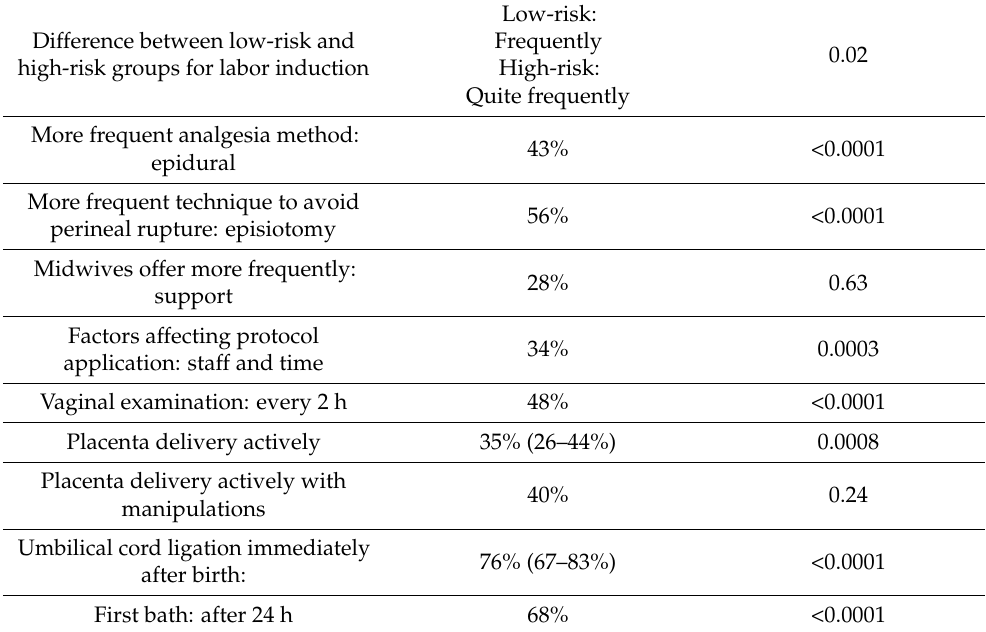
Table 4. Difference between low-risk and high-risk